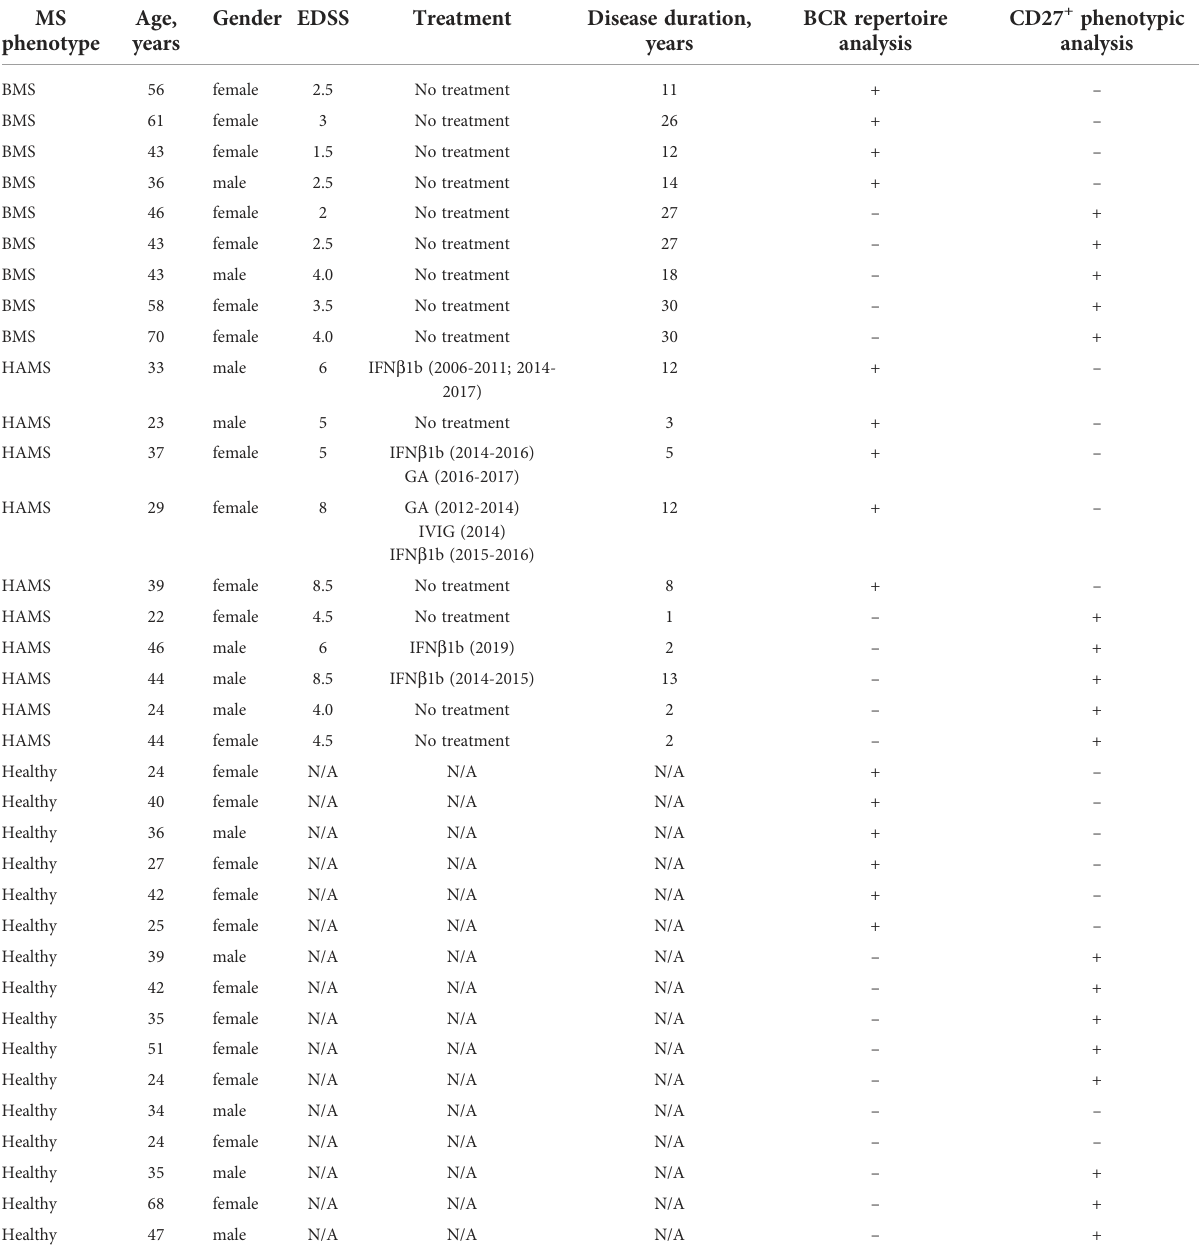
TABLE 1 Baseline and clinical characteristics of patients with multiple sclerosis and healthy